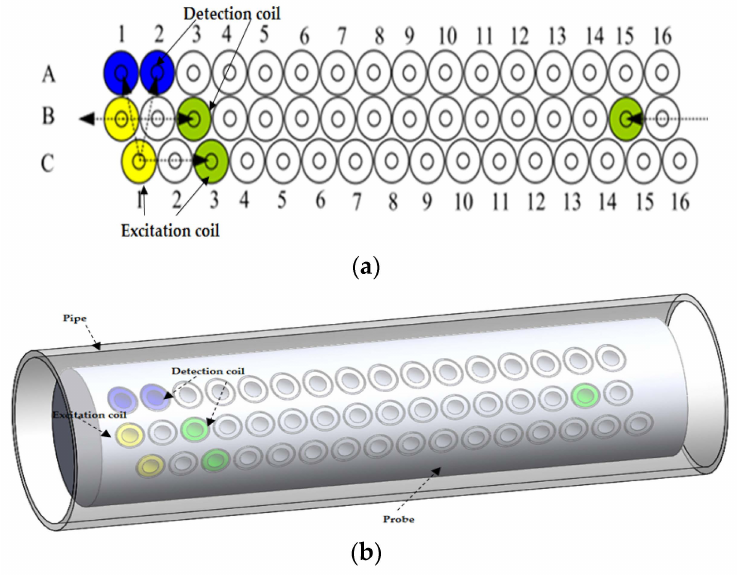
Figure 8. Axial and circumferential channels of array probes: ( a ) Excitation and detection coil configuration; ( b ) illustration of the excitation and detection coil location on the eddy current testing probe for an array